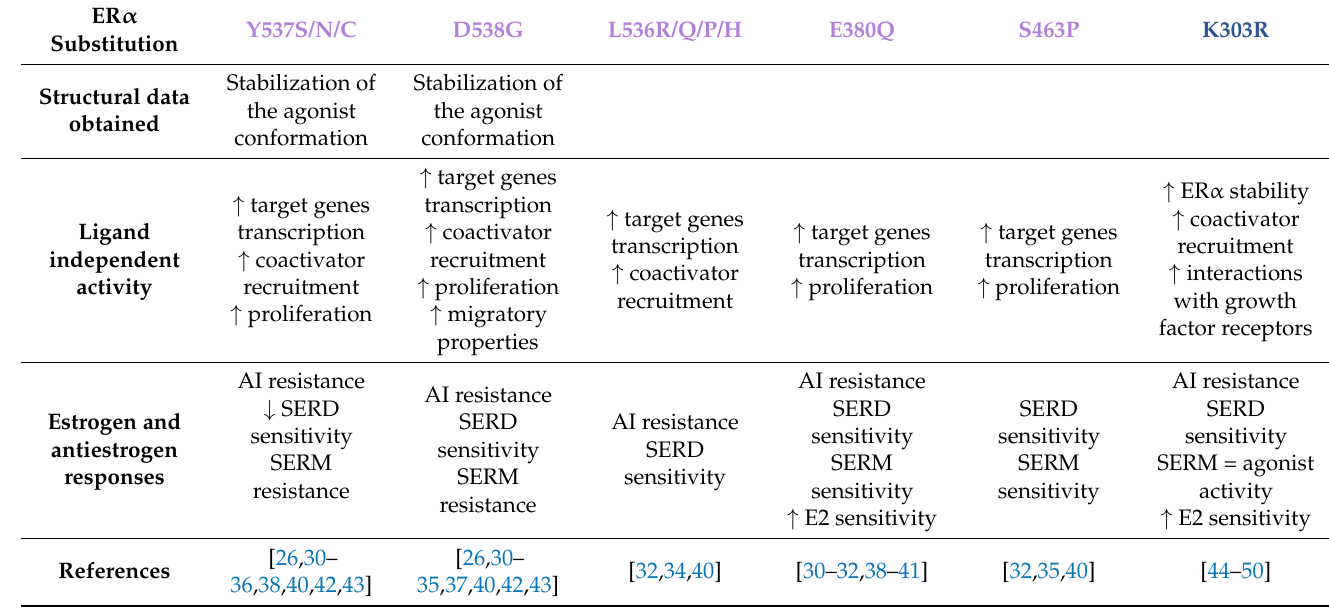
Table 2. Major ER α mutations discussed in this review and a summary of their characteristics. Purple: mutations in the LBD; blue: mutations outside the LBD (AI: aromatase inhibitor; SERD: selective estrogen receptor downregulator; SERM: selective estrogen receptor modulator; E2: